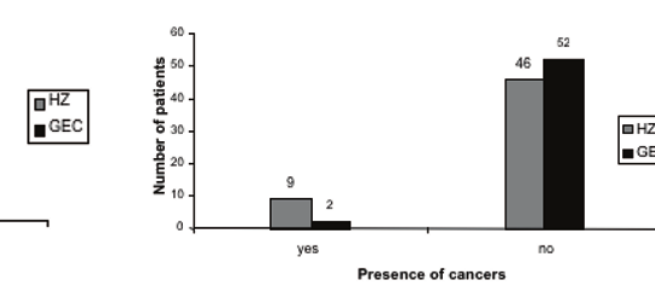
Figure 2. Comparison of herpes zoster and control group in the frequency of herpes zoster due to the alcohol consumption, the Clinic for Infectious Diseases UCH Mostar in the period from January, 1 st 2005 to December, 31 st 2010. (HZ–Herpes zoster, GEC–gastroenterocolitis).